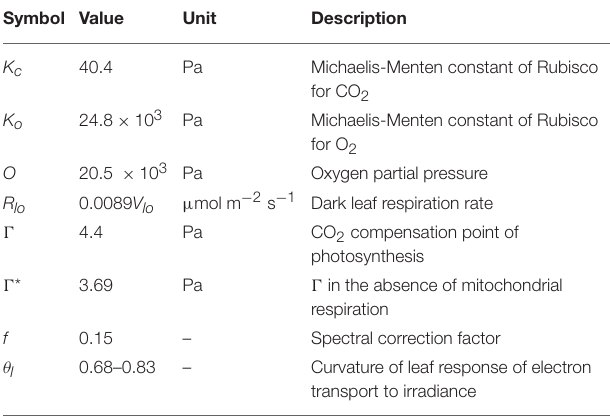
TABLE 3 | Photosynthetic parameters and constants of the FvCB model at 25 ◦